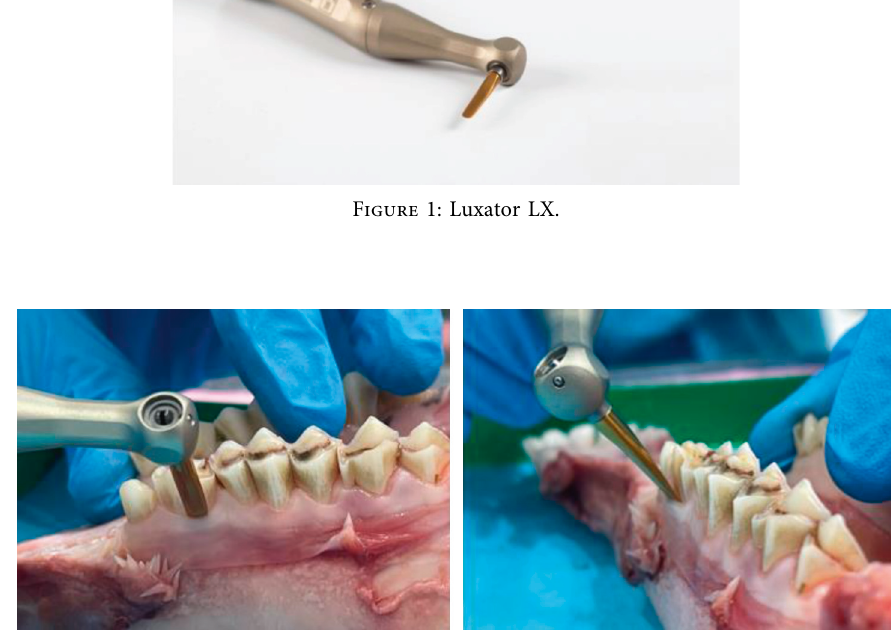
Figure 2: Extraction using the Luxator LX.